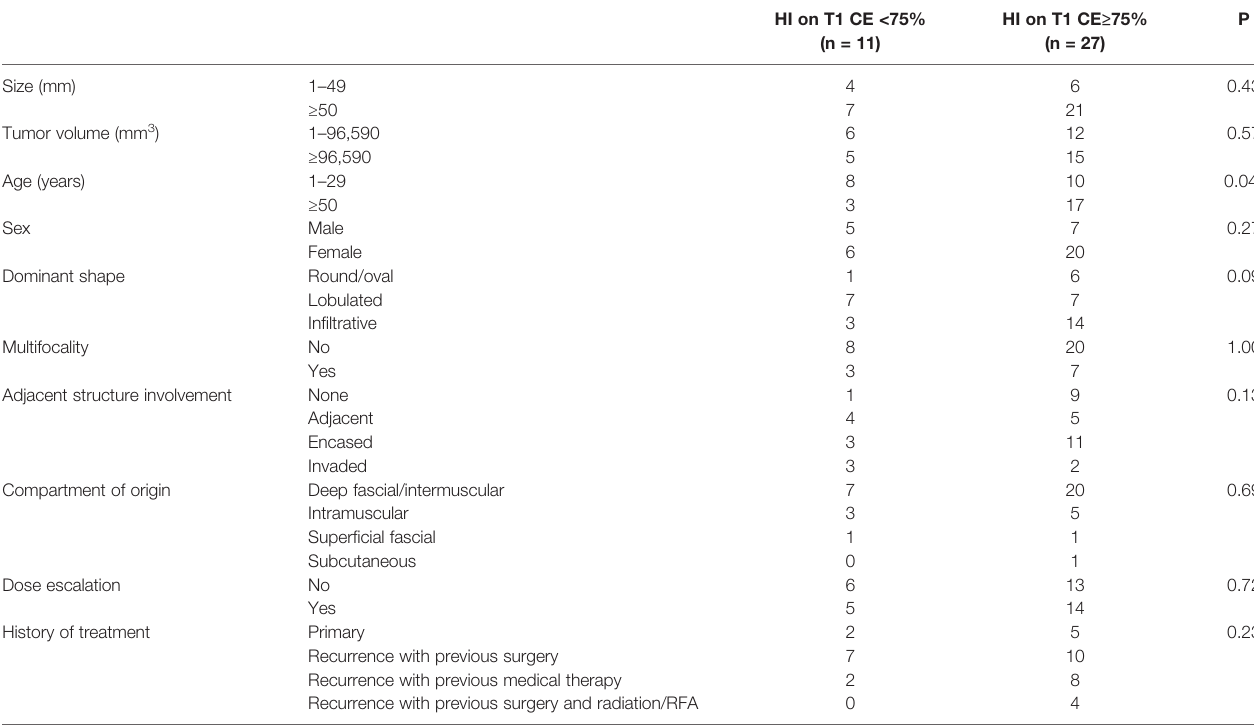
TABLE 5 | Characteristics of the 38 DF patients with imatinib treatment strati fi ed by HI proportion.